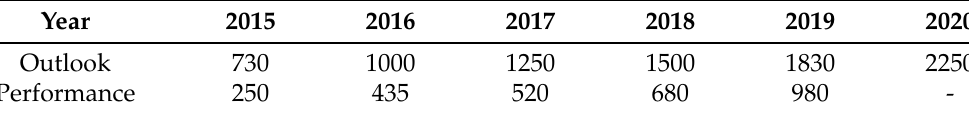
Table 1. AMI supply forecast (existing) and performance (Unit: 10,000,